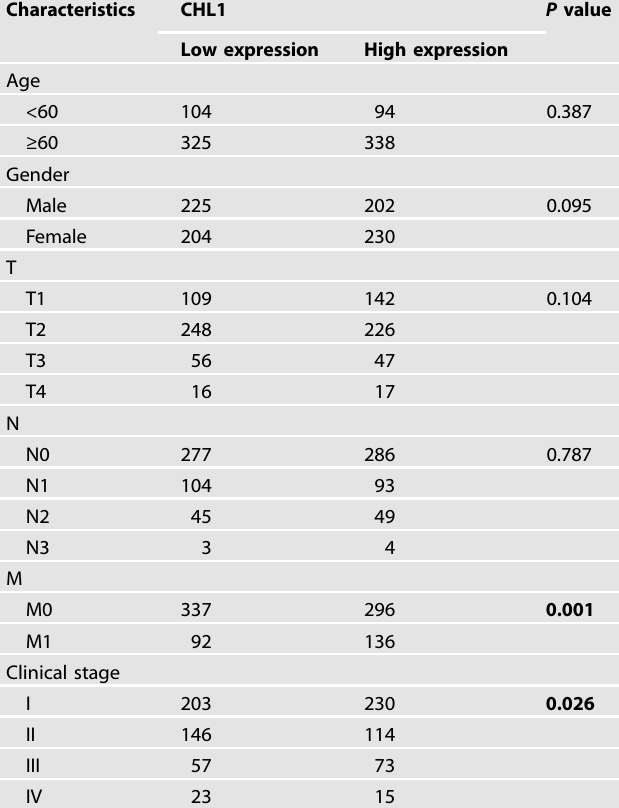
Table 1. The clinical characteristics of CHL1 in the TCGA-NSCLC